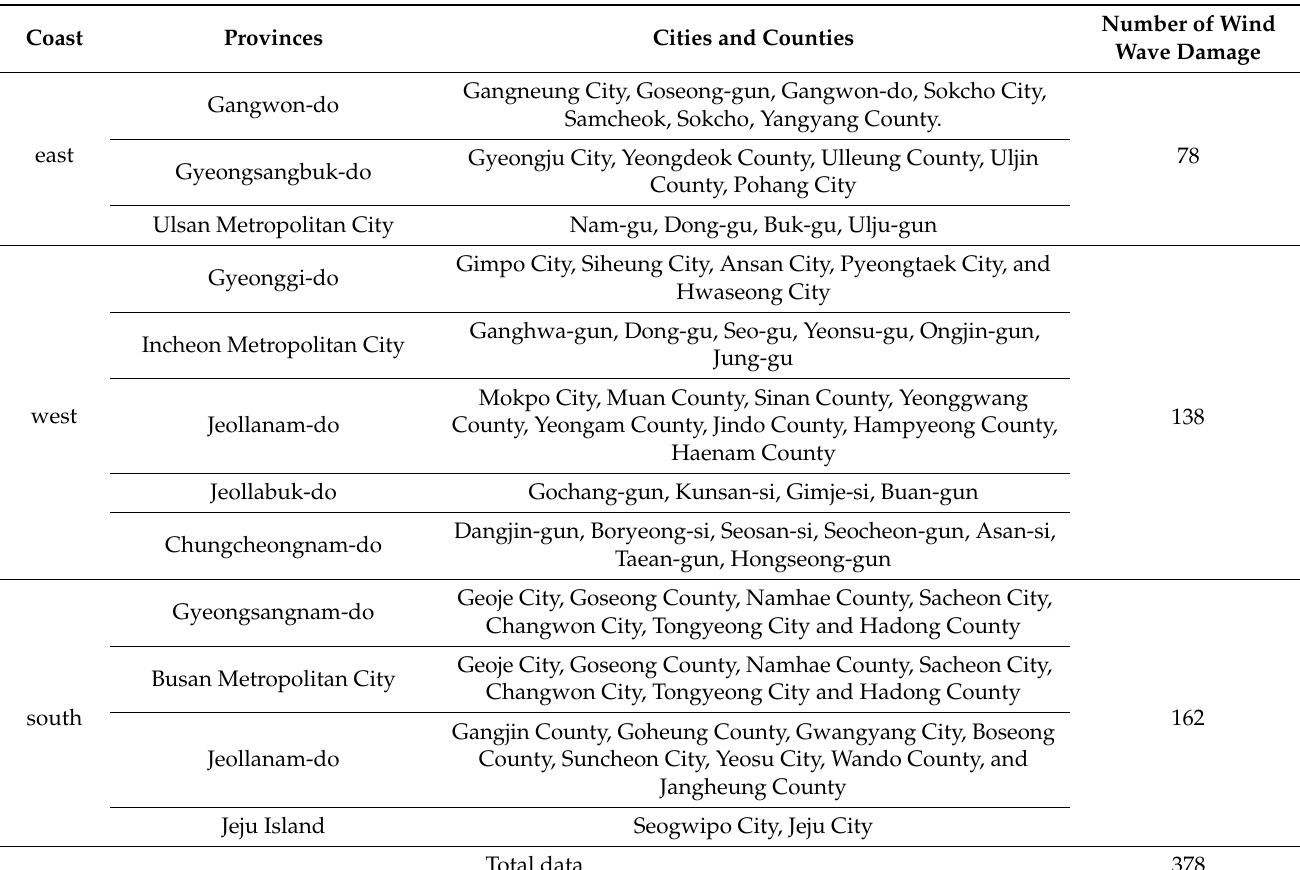
Table 1. Number of Wind Wave Damage Events by